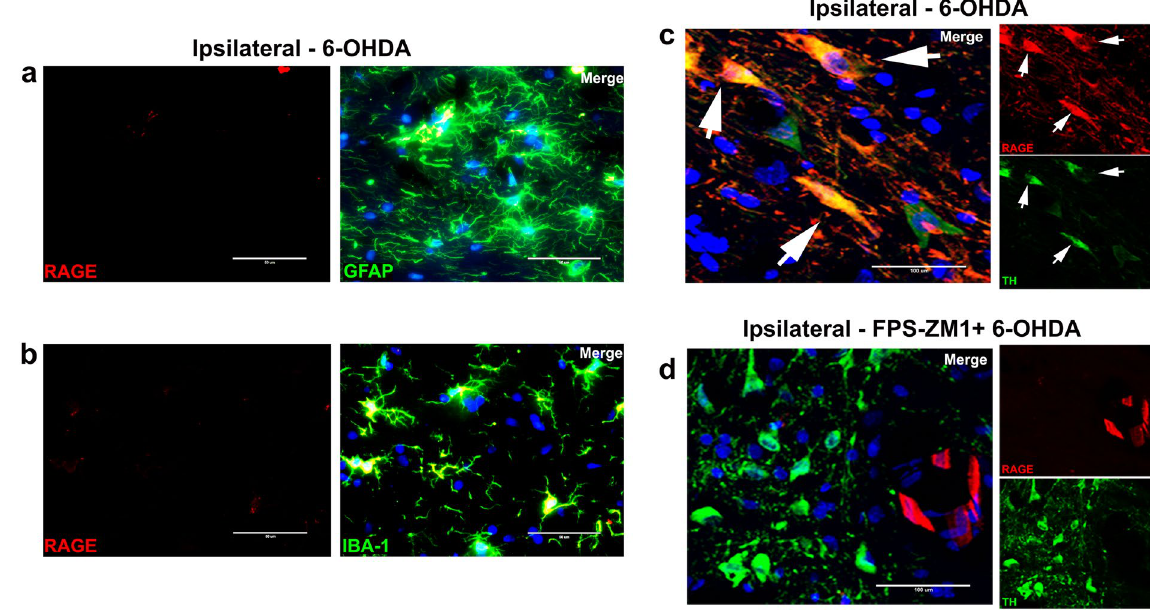
Figure 2. RAGE preferentially binds to dopaminergic neurons. Rats were prepared for immunofluorescence 15 days after 6-OHDA administration. The sections were co-immunostained for markers specific to different cell types and RAGE to evaluate the morphology and co-localization. ( a ) GFAP + RAGE, ( b ) IBA-1 + RAGE. The microscopy images were taken with 50 μ m of magnification. ( c ) Confocal representative immunofluorescence images of SN co-immunostained for TH, RAGE and DAPI to ipsilateral 6-OHDA-induced and ( d ) ipsilateral FPS-ZM1 + 6-OHDA. The confocal microscopy images were taken with 100 μ m of magnification and the z-axis layers are detailed in Sup. Fig. S1a and b. Representative immunofluorescence images of SN co-immunostained for different cell types ( n = 10 per group): Only ipsilateral sides are